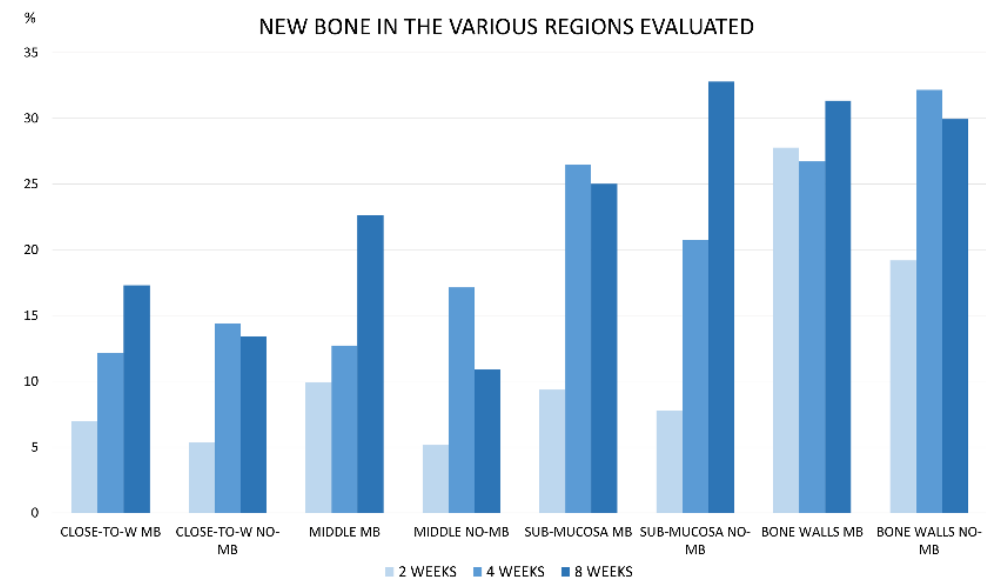
Figure 6. New bone formation in the different regions of the grafted area.